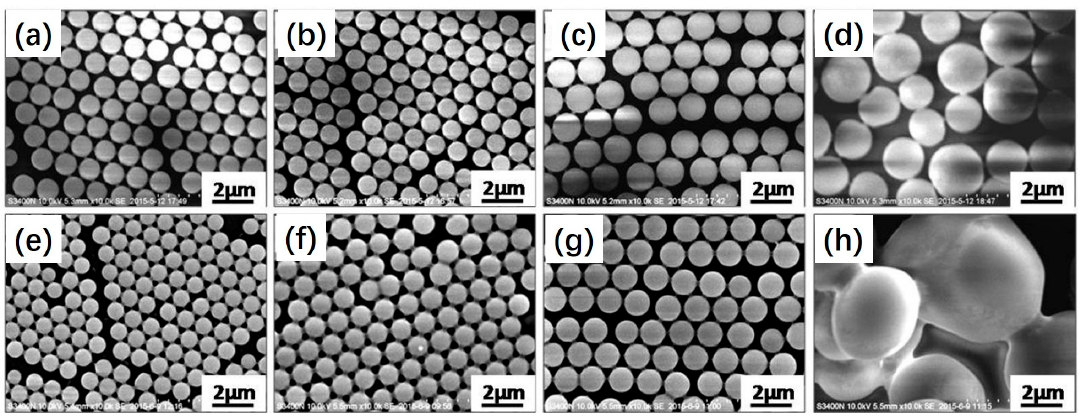
Figure 7. SEM images of polymeric microspheres prepared by photoinitiated RAFT dispersion polymerization at different ethanol/water ratios ( w/w ) with ( a – d ) 2 or ( e – h ) 6 wt % MAA: ( a , e ) 35/65, ( b , f ) 40/60, ( c , g ) 45/55, ( d , h )